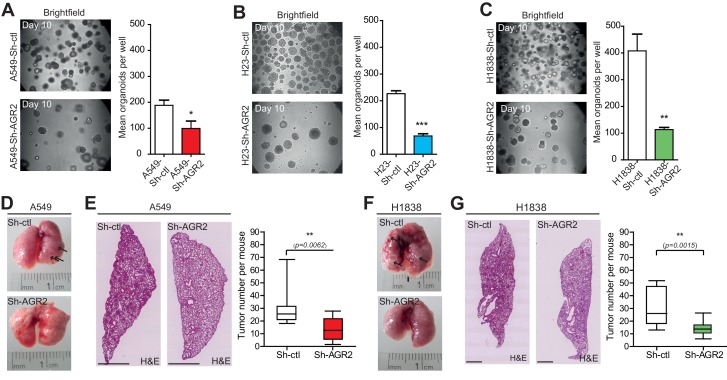
AGR2 knockdown reduces tumorigenicity and metastatic potential.(A–C) Representative brightfield pictures of tumor organoids grown in 3D from cells harboring Sh-ctl or Sh-AGR2 (three independent experiments). The bar graph shows the mean of organoids per well (mean ± SEM.) after 10 days of culture from three independent experiments. The p values (determined by Student's t test) are relative to Sh-ctl cells. *p≤0.05. **p≤0.01 and ***p≤0.001. (D, F) Representative pictures of the lungs in mice injected with Sh-ctl cells or Sh-AGR2 cells allowed to developed tumors for 2 weeks. Note the extensive lesions (white areas) on the surface of lungs from Sh-ctl mice and the relatively normal appearance of the lungs from Sh-AGR2 mice. (E, G) Representative H&E-stained sections for lungs injected with Sh-ctl cells or Sh-AGR2 cells (montage of x5 magnification of lung sections). Scale bars, 1 mm. Box plot showing the mean number of tumors per mouse in Sh-ctl (n=6) vs Sh-AGR2 (n=6) groups. The p values (determined by Student's t test) are relative to Sh-ctl cells. **p≤0.01.